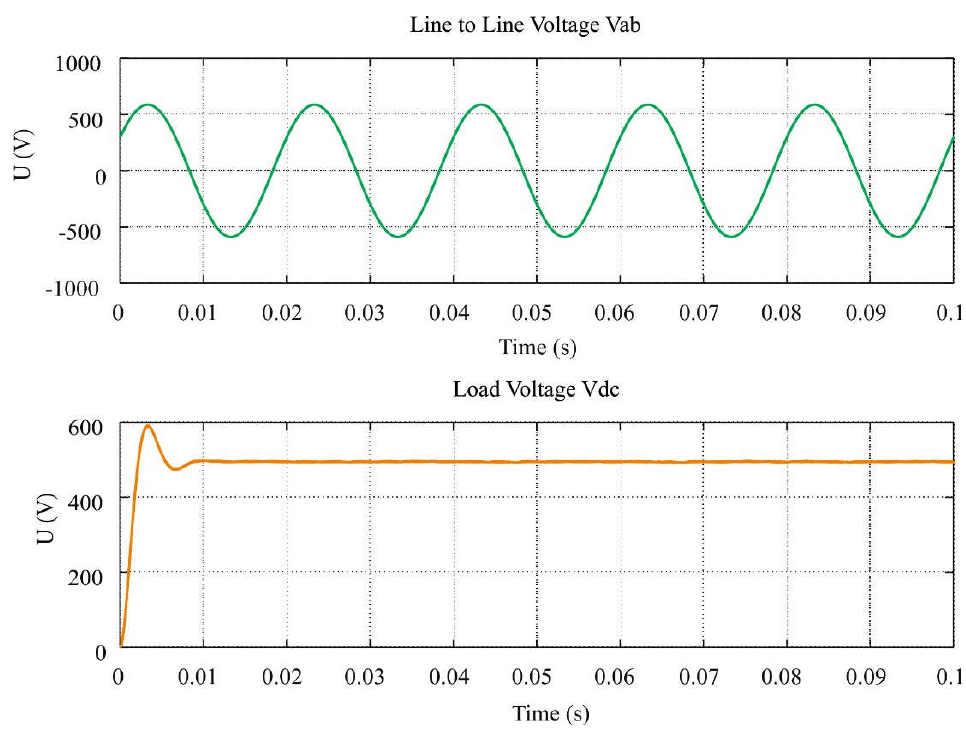
Figure 8. Voltage waveforms in the ATRU unit, based on the structure of a 24-pulse rectifier for output voltage 450 (V).